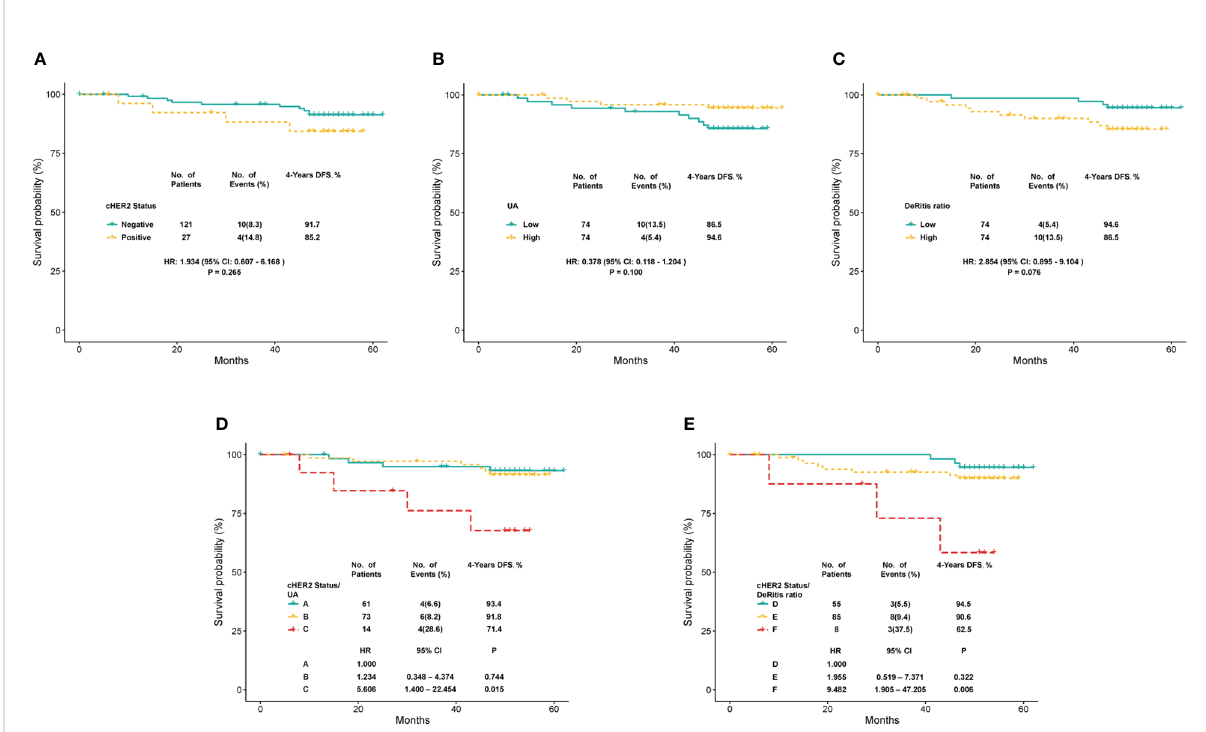
FIGURE 6 Kaplan – Meier survival curve for 4-year disease-free survival in breast cancer patients with HER2- primary tumor, strati fi ed by (A) cHER2 status, (B) UA, (C) De Ritis ratio, and (D) combination of cHER2 status and UA (A: without cHER2+/UA-high, B: without cHER2+/UA-low or with cHER2 +/UA-high, and C: with cHER2+/UA-low), (E) combination of cHER2 status and De Ritis ratio (D: without cHER2+/De Ritis ratio -low, E: without cHER2+/De Ritis ratio - high or with cHER2+/De Ritis ratio -low, and F: with cHER2+/De Ritis ratio -